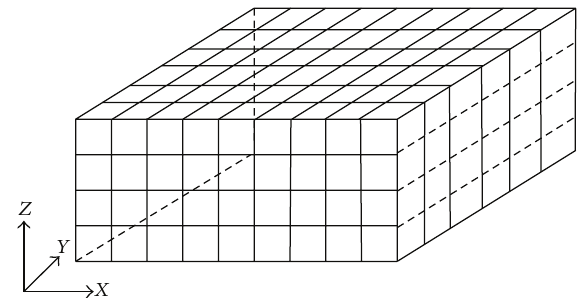
Figure 6: 3D mesh dissections on the actual environment.